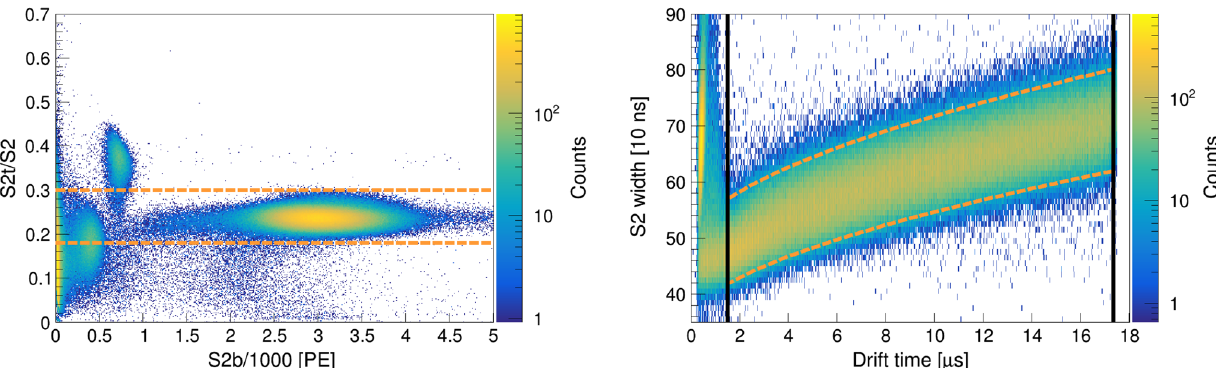
(b) S2 width cut to remove accidental coincidences and remaining gas events (see text). The drift region defined by the cathode and the gate are marked by solid black lines.